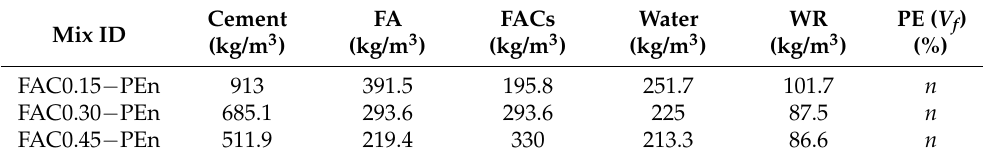
Table 3. Mix proportions of GLECCs.